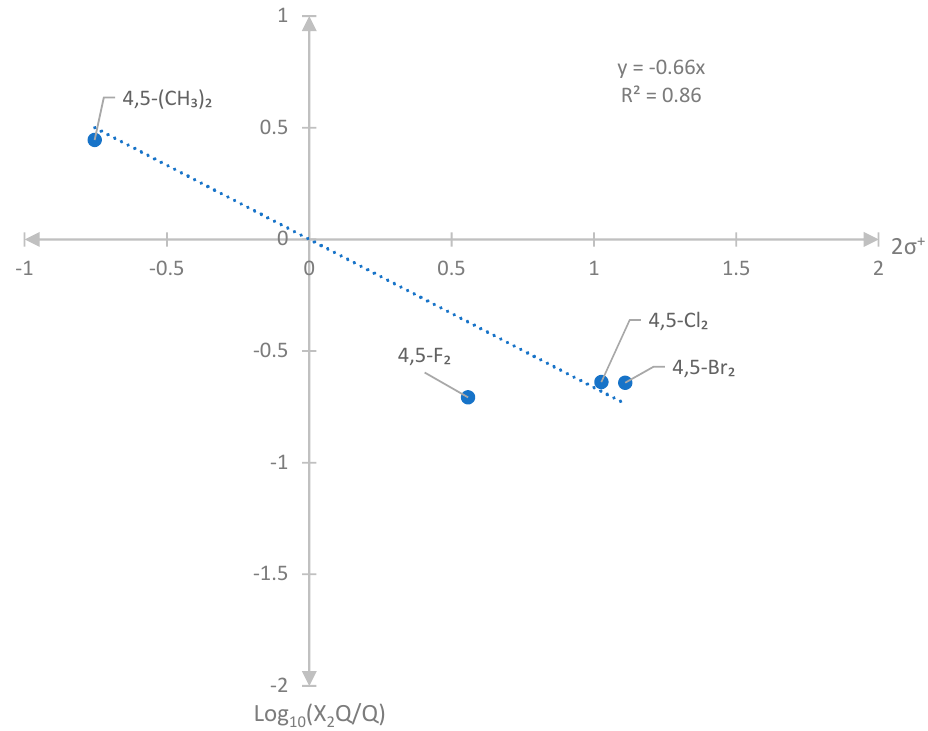
Figure 6. Hammett plot of X 2 Q/Q ratio with doubled standard composite σ + constants.